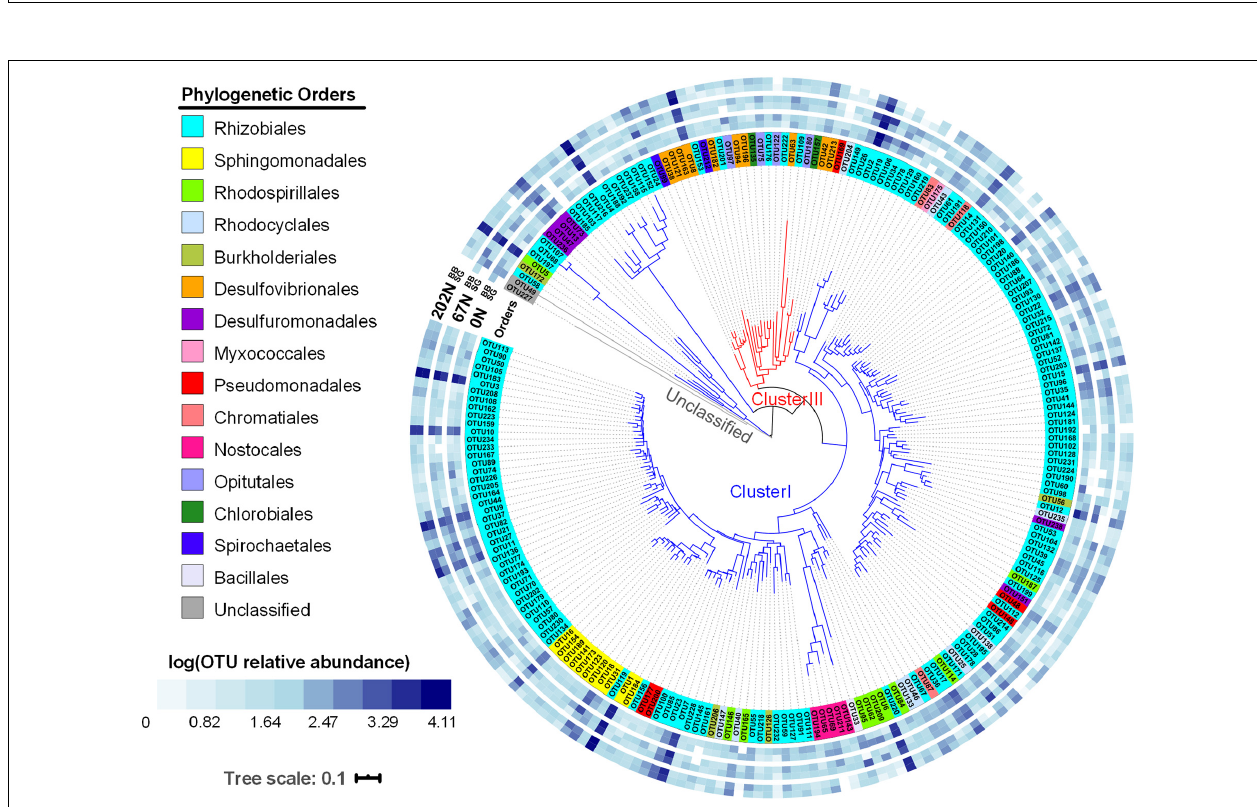
FIGURE 5 | Circular neighbor-joining phylogenetic tree of the top 224 abundant nifH OTUs (OTUs with ≥ 100 reads). Tree leaves on the inner circle highlighted by colors show the affiliation to different phylogenetic orders. The outer blue-and-white heatmap circles show the logarithmic value of mean OTU relative abundances in percentages in different N fertilization rates and grass species (all three seasons combined). 0N, no N fertilization; 67N, 67 kg N ha − 1 fertilization; 202N, 202 kg N ha − 1 fertilization; SG, switchgrass; BB, big bluestem.